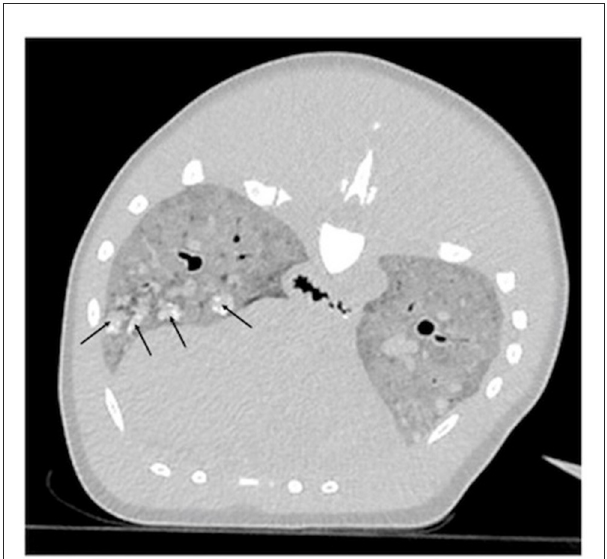
FIGURE1 Computed tomographic (CT) transverse image centered on the mid-thorax reconstructed in a lung algorithm of an adult male Stenella frontalis . Diffusely, the pulmonary parenchyma has a severe increase in soft tissue attenuation and contains multifocal and ill-defined soft tissue attenuating nodules, some of which have mineral foci (black arrows).